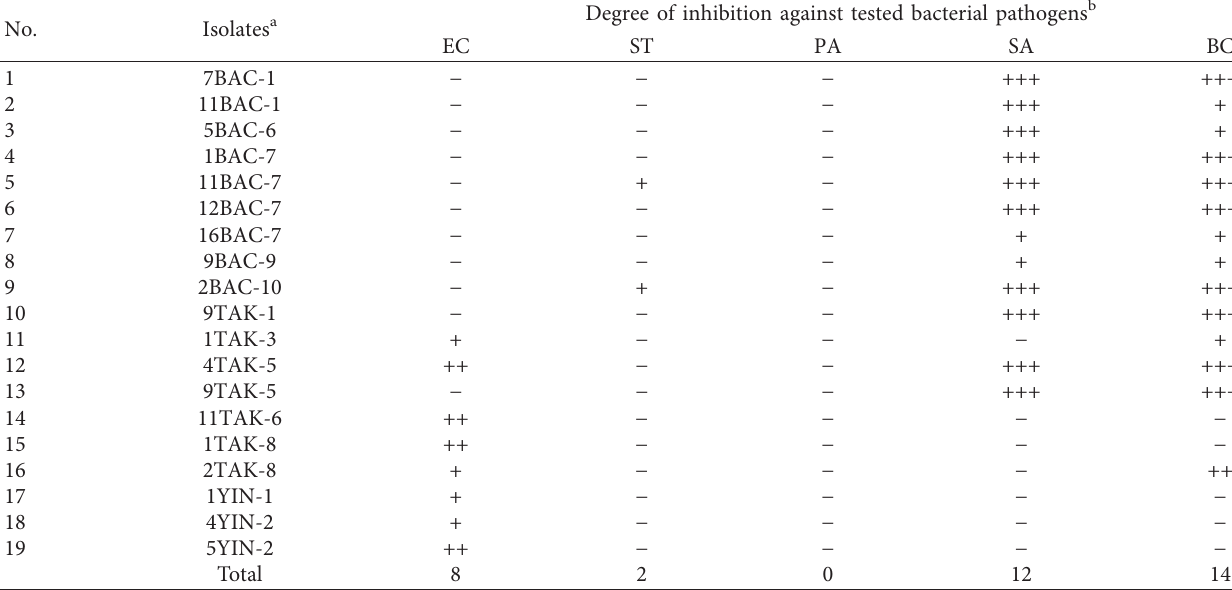
Table 2: Primary antibacterial screening of 19 potent Actinomyces isolates against 5 pathogenic bacteria using the cross-streak method.